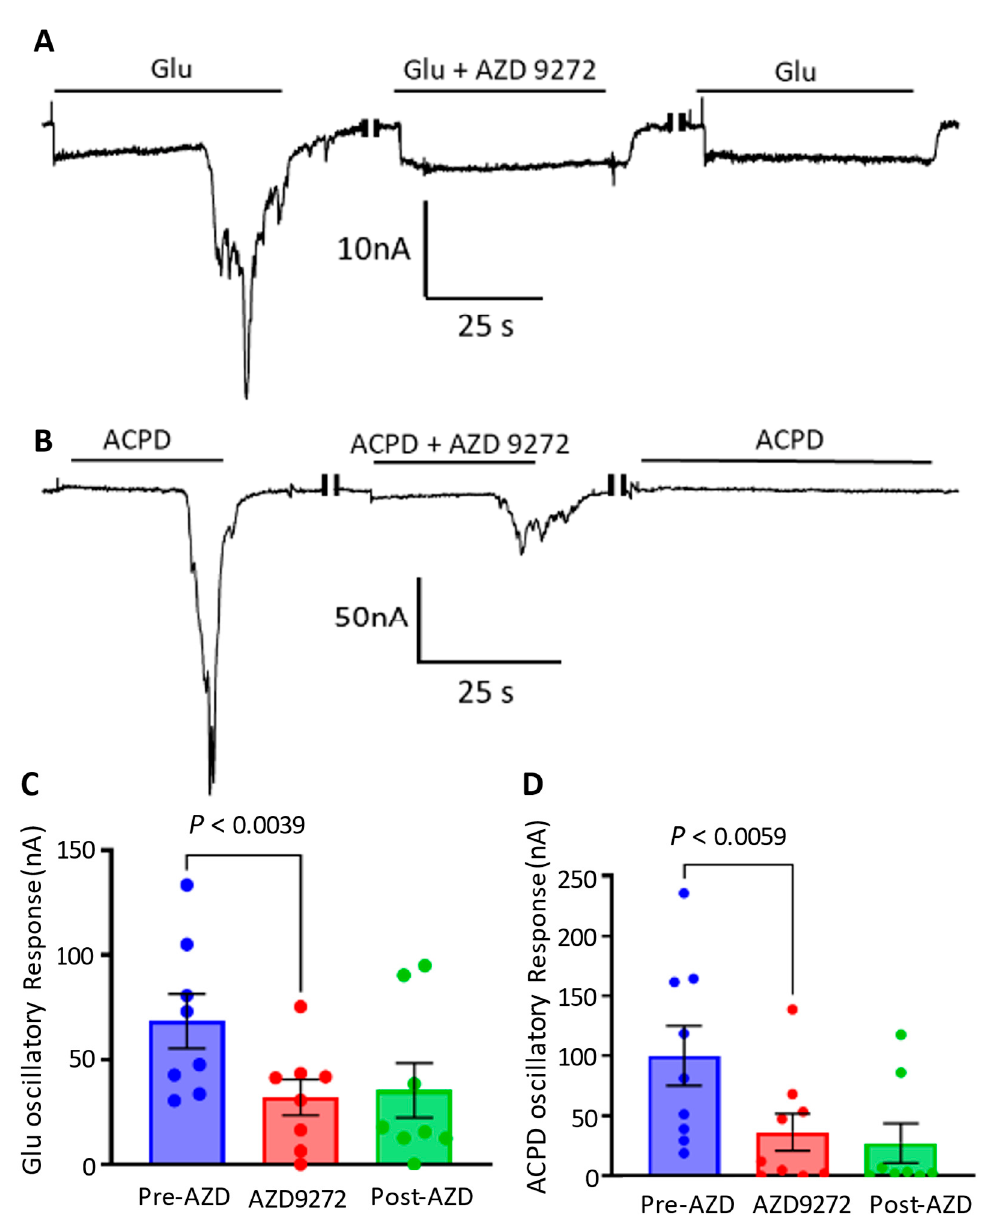
Figure 5. Inhibition of mGluR5 affects presence of metabotropic glutamate oscillations. ( A ) Glutamate currents of a single microtransplanted oocyte in response to application of the mGluR5 antagonist, AZD 9272, with each method of application separated by 4 min of wash by Ringer’s solution. Antagonism of mGluR5 alongside glutamate agonism displayed a significant reduction of responses ( C ), a trend which would prolong into the washing period ( n = 9 oocytes from 2 frogs). ( B ) ACPD currents of a single microtransplanted oocyte in response to application of the mGluR1 antagonist, AZD 9272, with each method of application separated by 4 min of wash by Ringer’s solution. Blocking of mGluR5 with ACPD ( D ) showed a significant reduction in response that persisted into the post-antagonist application ( n = 9 oocytes from 2 frogs).